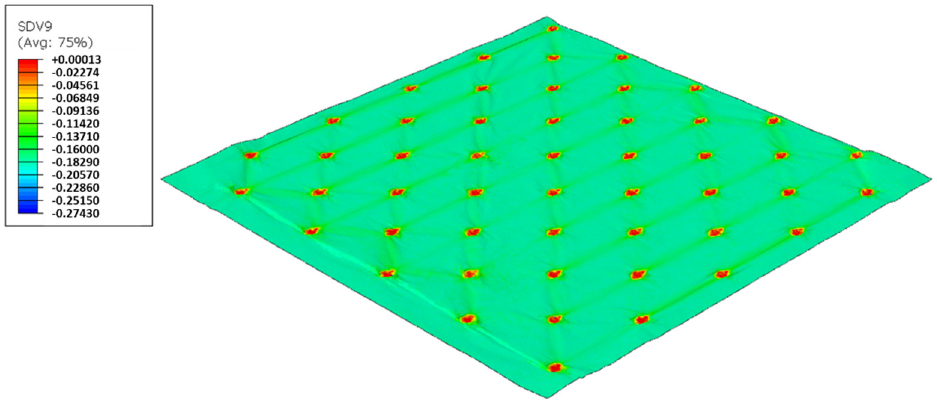
Figure 28. Deco die 48_60 Sh-A (NR BG/SBR PR), Plastic field.